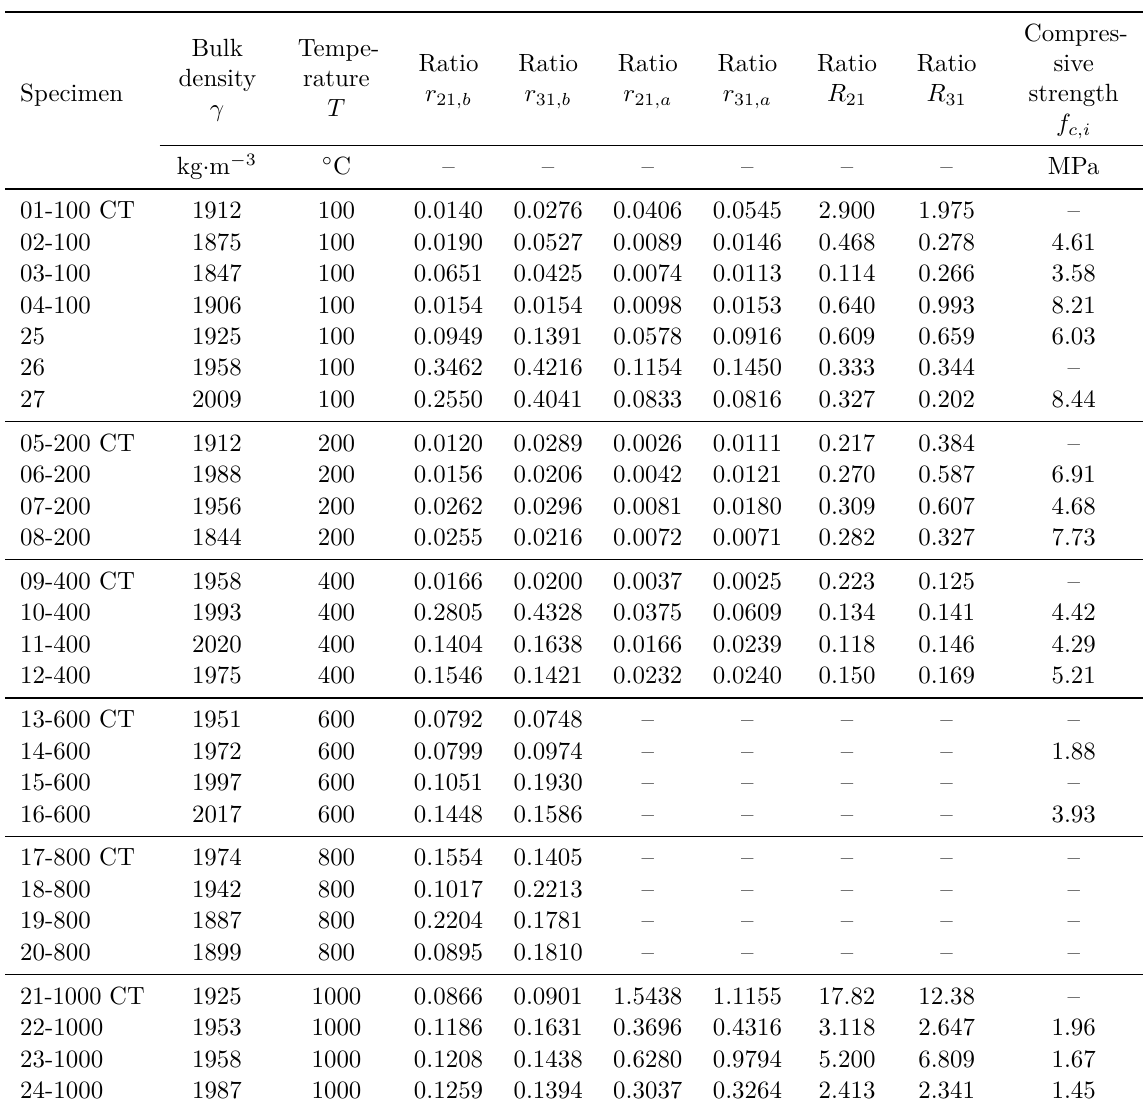
Table 1. Measured data, results of the ultrasonic pulse method and informative compressive strengths.